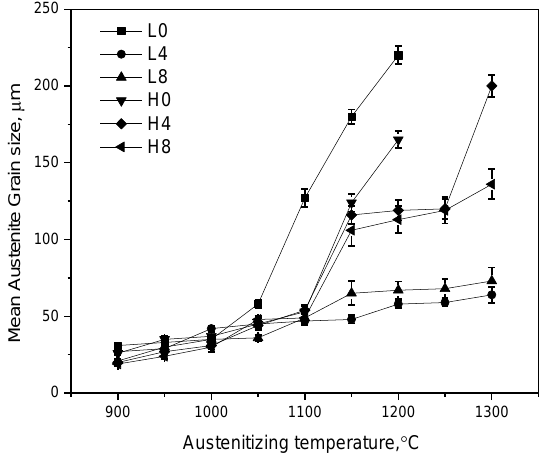
Figure 11. Mean austenite grain size as a function of reheating temperature.